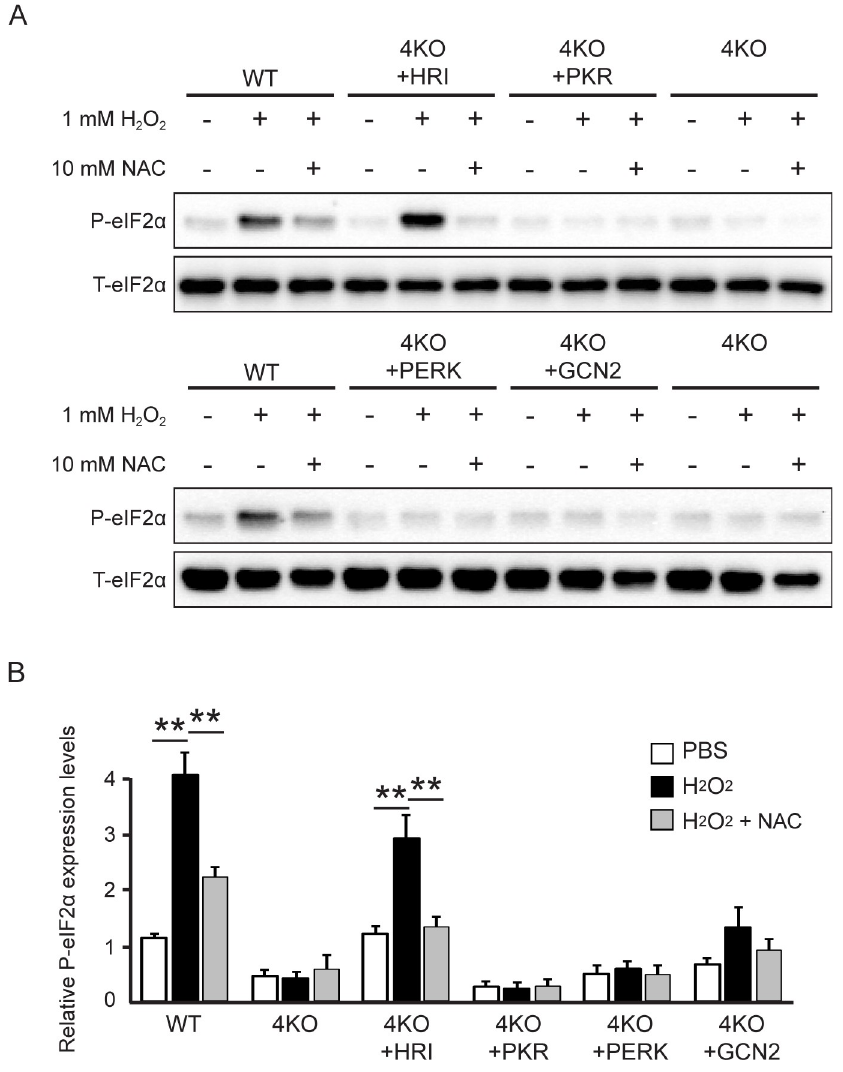
Fig 3. The eIF2 α kinase HRI is responsible for ROS-induced eIF2 α phosphorylation. ( A ) Representative immunoblots of phosphorylated eIF2 α and total eIF2 α in WT, 4KO and single eIF2 α kinase-rescued 4KO MEF cells 1 h after 1 mM H 2 O 2 treatment with or without 10 mM NAC. ( B ) Densitometry quantification of phosphorylated eIF2 α normalized to the total eIF2 α level in WT, 4KO and single eIF2 α kinase-rescued 4KO MEF cells 1 h after 1 mM H 2 O 2 treatment with or without 10 mM NAC. Error bars show the means ± SEM ( n = 4–9, �� P <